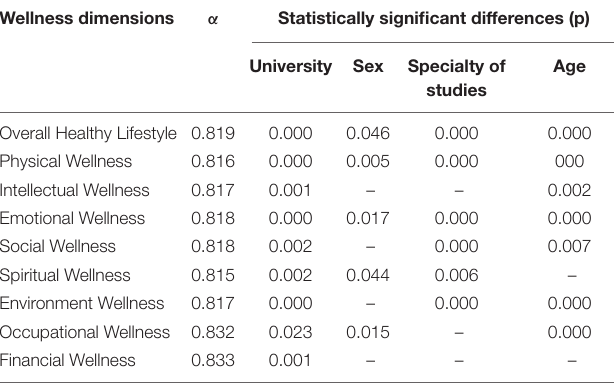
TABLE 3 | Wellness dimensions and statistically significant differences between university, sex, age, and specialty of studies. Wellness dimensions α Statistically significant differences